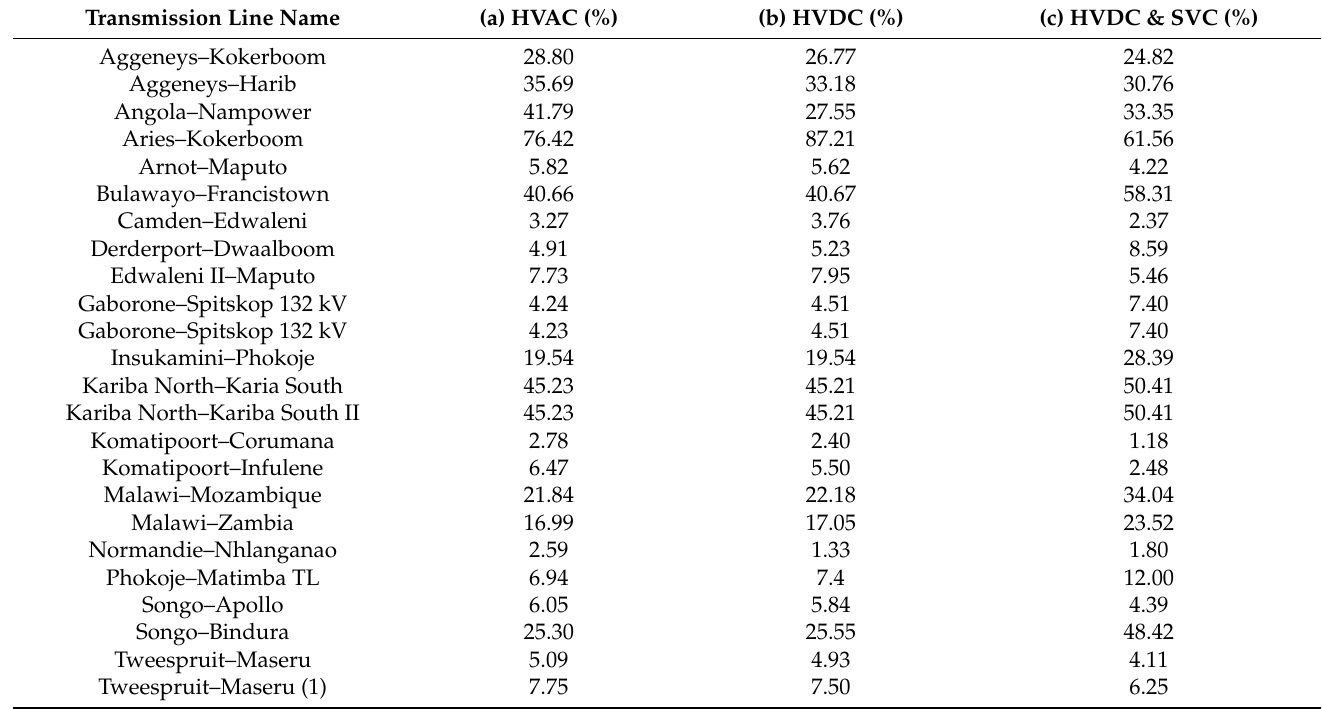
Table 5. Different transmission line loading profiles for the SARG network.